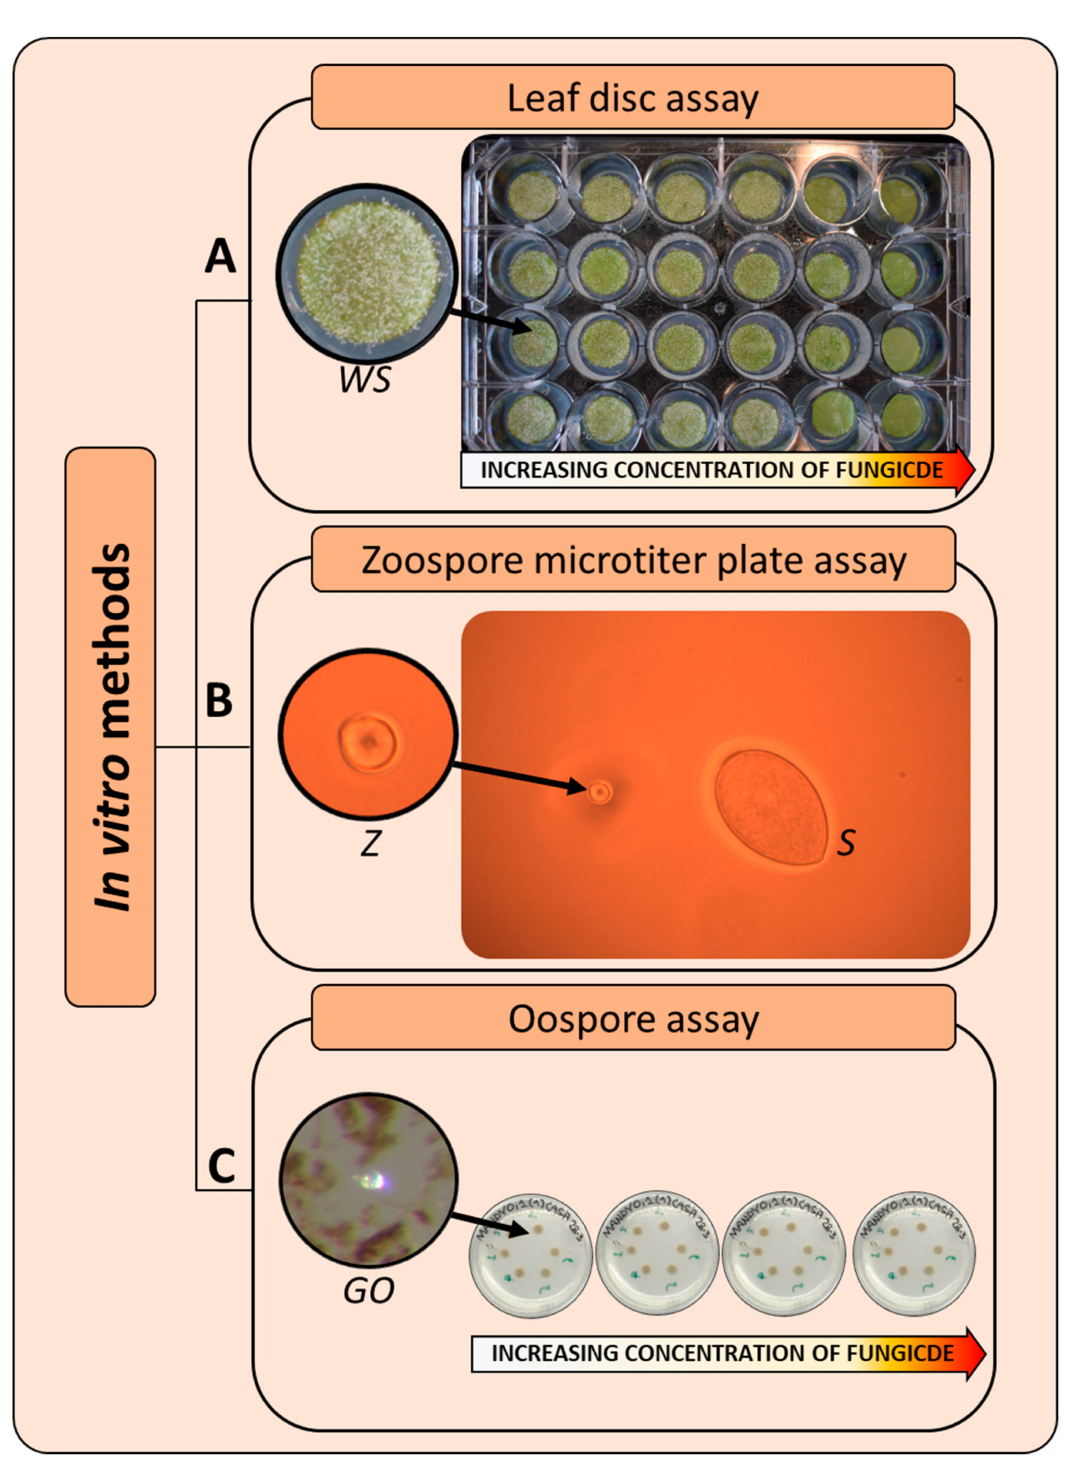
Figure 5. In vitro testing for P. viticola based on leaf disc bioassay ( A ), zoospore microtiter plates ( B ), and oospore testing ( C ). ( A ) microtiter plate containing leaf discs showing white sporulation (WS). Columns were treated with increasing concentrations of fungicide. ( B ) Sporangium (S) and free zoospore (Z) in liquid medium. ( C ) Agar plates containing increasing concentrations of fungicides and inoculated with oospore suspensions. The number of germinated oospores (GO) is counted and used to calculate the germination percentages at each concentration and to estimate the EC 50 values of the population or the percentage of resistant oospores at a discriminatory concentration of